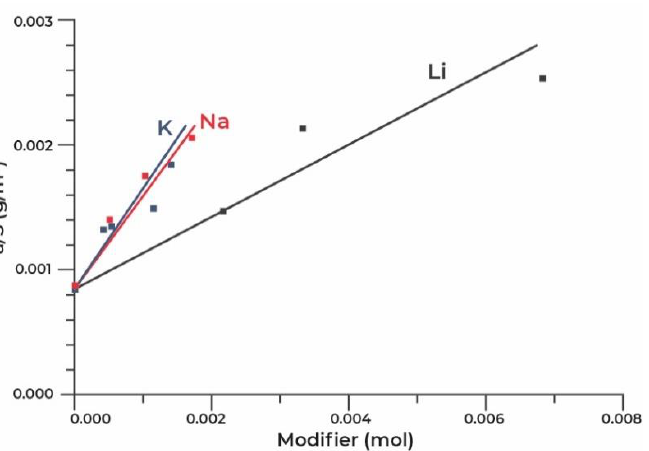
Figure 5. Dependence of the capacity of the adsorbent surface unit on the mole content of the modifier.